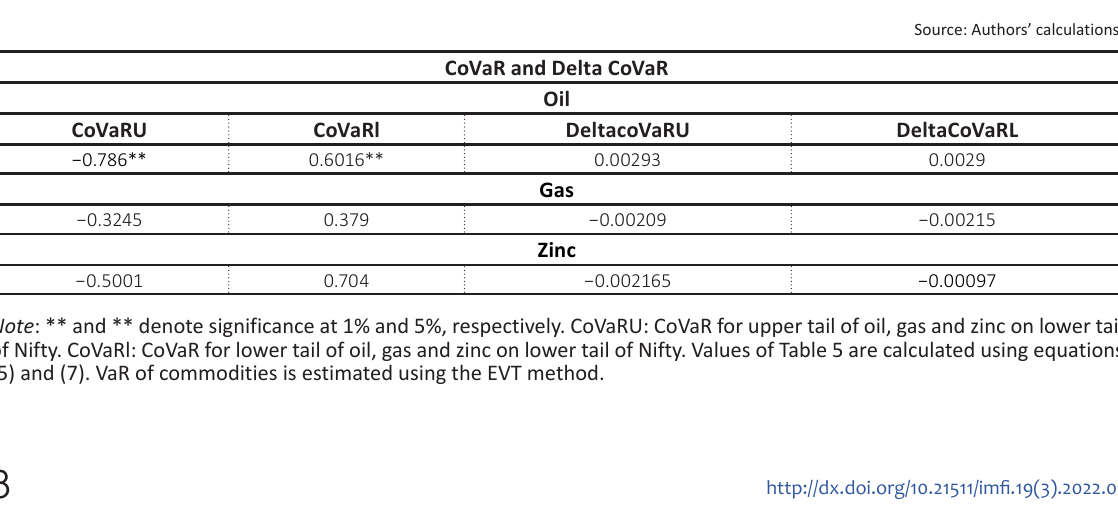
Table 5. Risk transmission from commodity futures to the Nifty 500 index using CoVaR and Delta